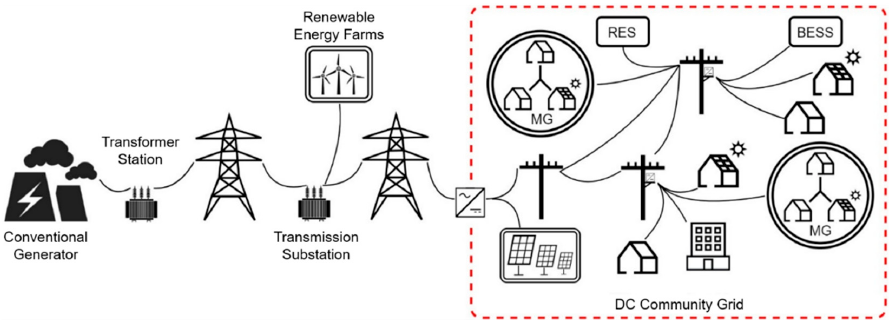
Figure 1. Schematic of DC community perspective. The DC-COM can autonomously operate from the AC grid or interconnect with the AC grid seamlessly.